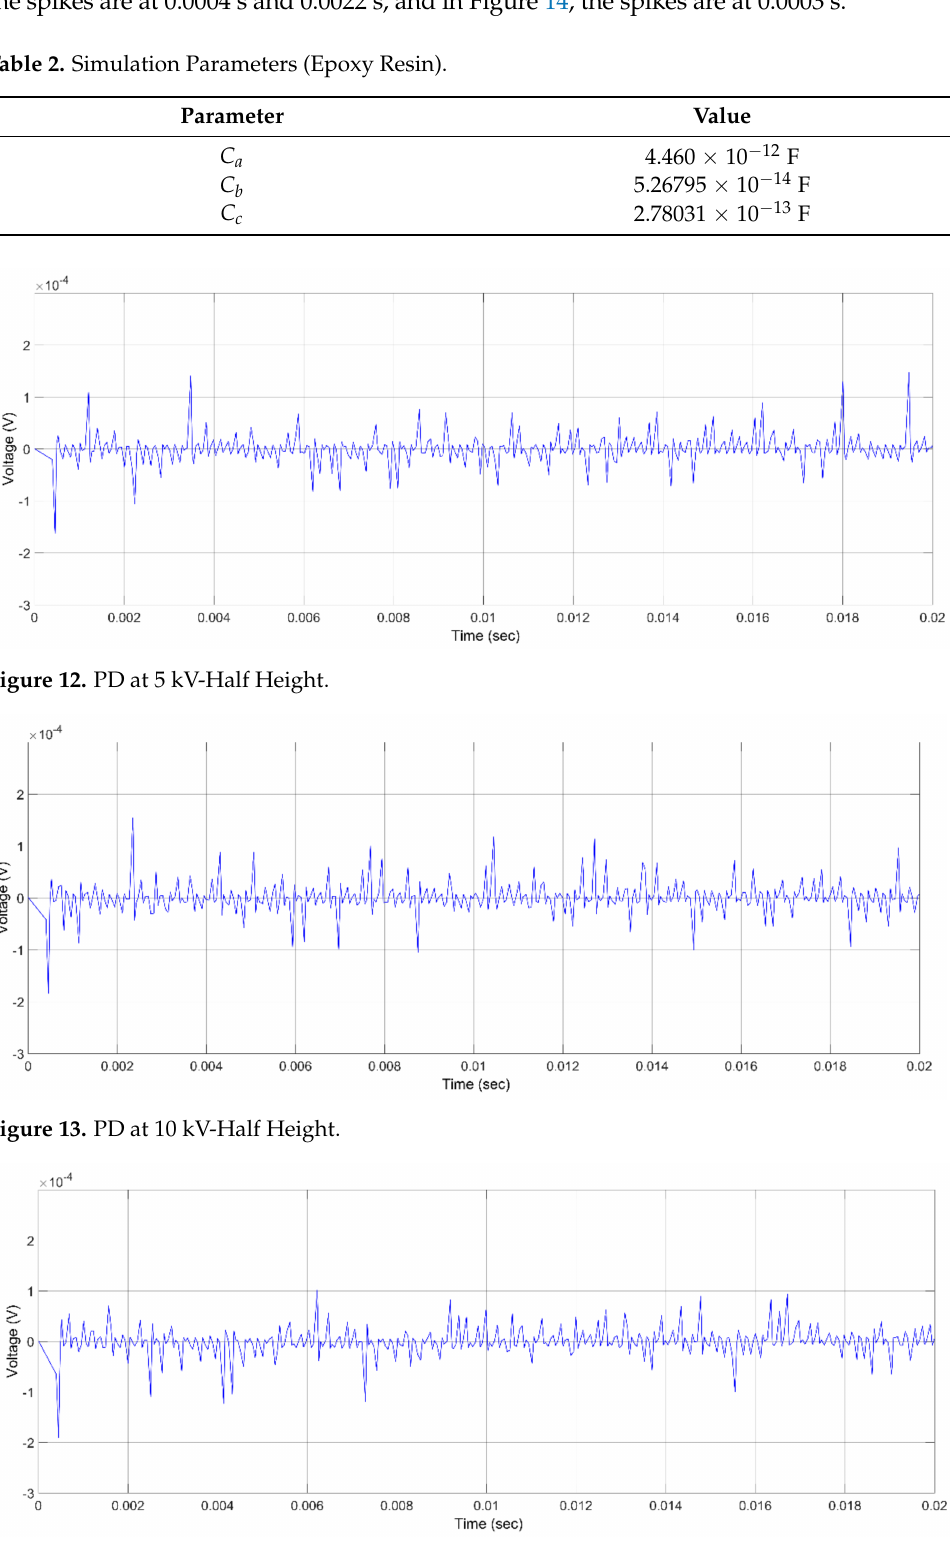
Figure 14. PD at 15 kV-Half